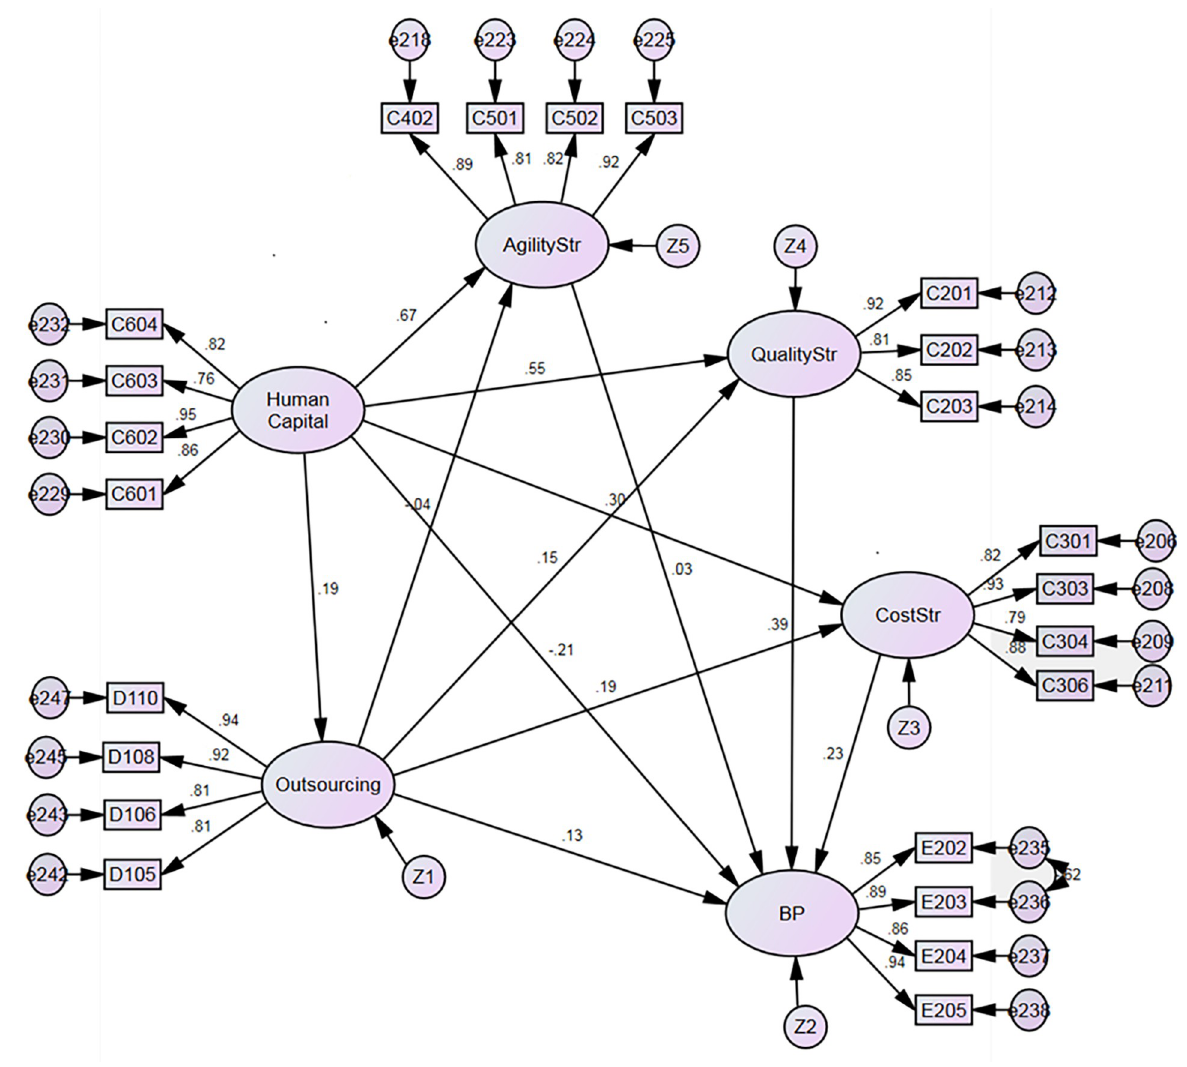
Fig 3. Structural model results for